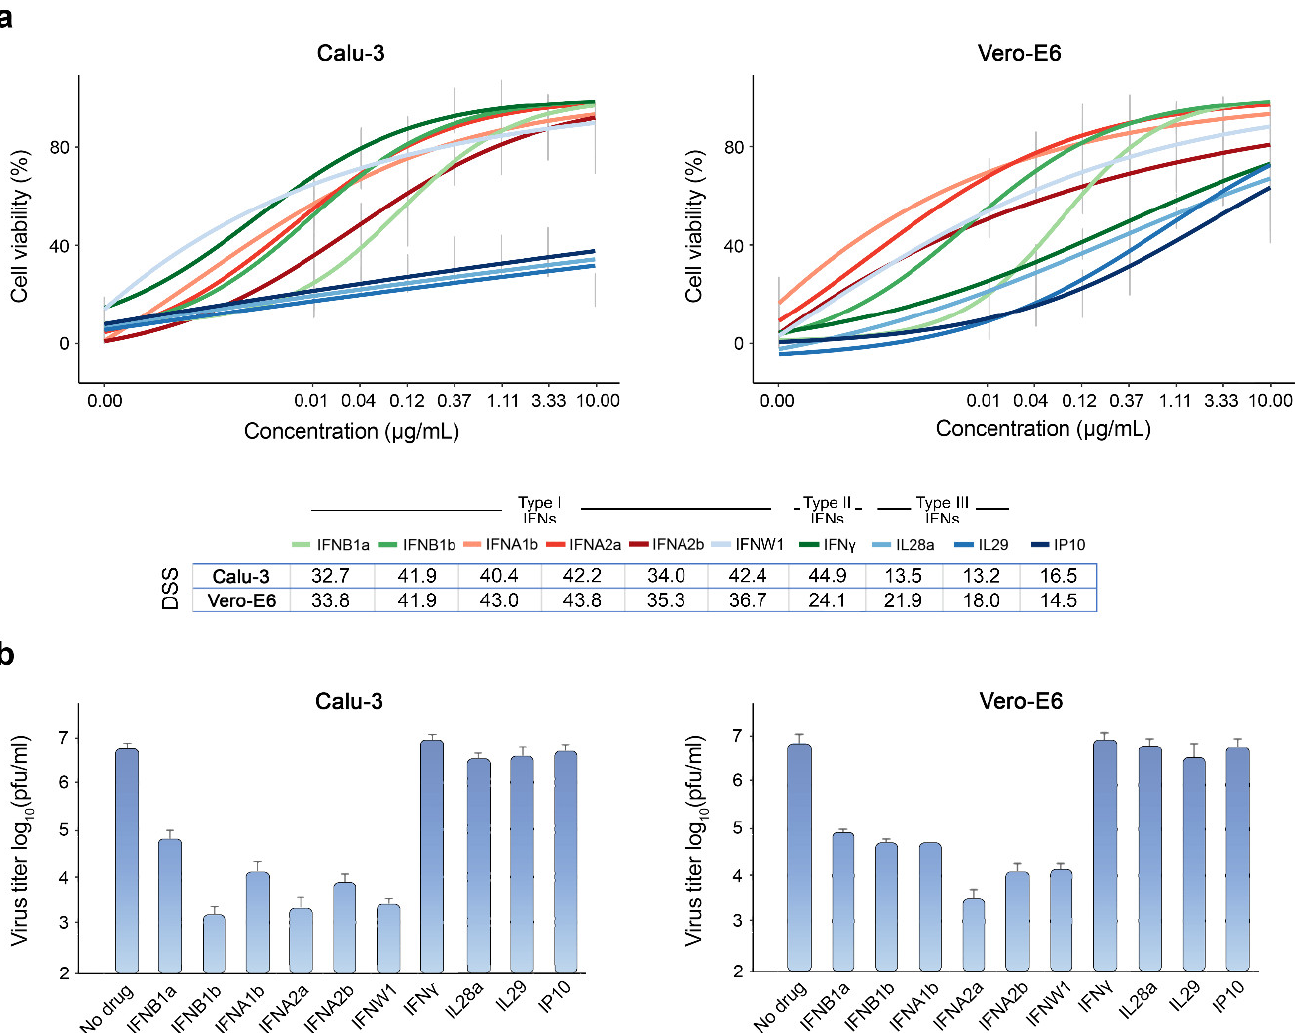
Figure 1. Type I IFNs rescue Calu-3 and Vero-E6 cells from SARS-CoV-2-mediated death and attenuate virus replication. ( a ) The effect of different doses of IFNs on viability of SARS-CoV-2-infected (moi = 0.01) Calu-3 and Vero-E6 cells. Cell viability was determined using the CTG assay at 72 hpi. Mean ± SD; n = 3. The anti-SARS-CoV-2 activity of the IFNs was quantified using drug sensitivity scores (DSS). ( b ) The effects of IFNs on viral replication, measured by plaque reduction assay. Mean ± SD; n = 3. Statistical testing was performed using pairwise Wilcoxon Rank Sum Tests and the results can be found in Table S2.